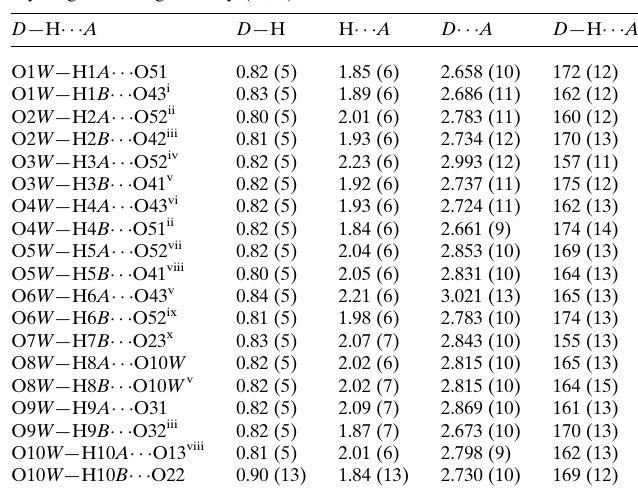
Table 1 Hydrogen-bond geometry (A˚ , (cid:5) ).